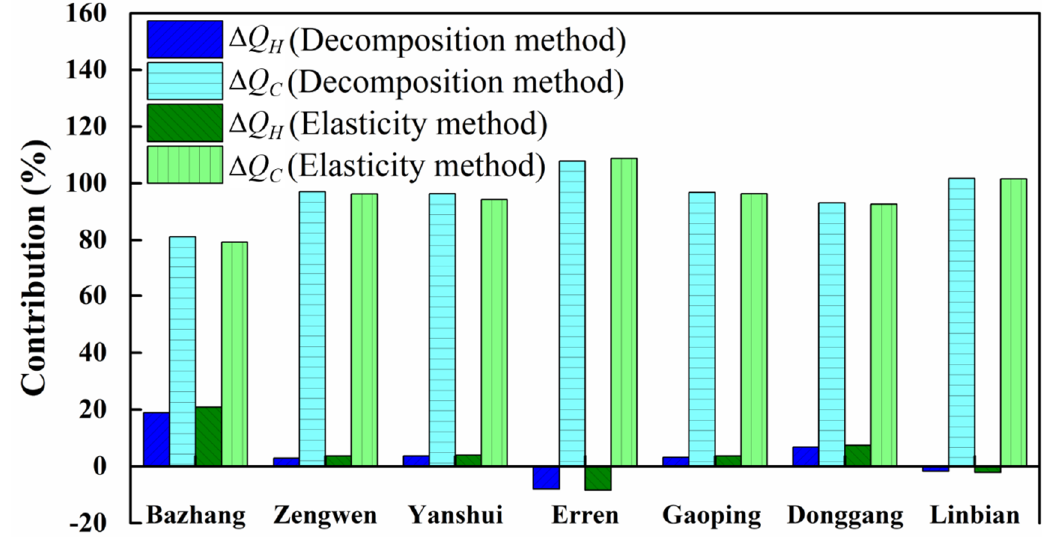
Figure 7. Comparative contributions of climate ( ∆ Q C ) and anthropogenic ( ∆ Q H ) factors impacting the streamflow change using two quantified methods.